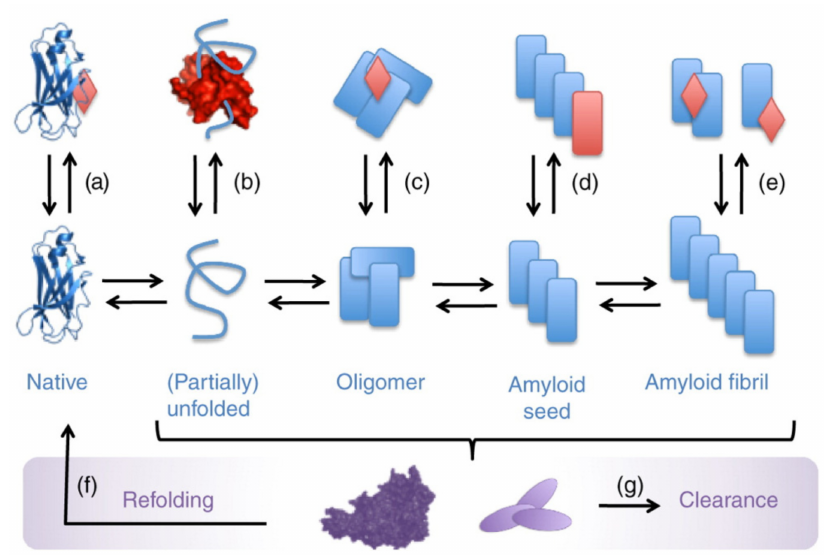
Figure 4. Schematic illustration of strategies to inhibit the formation of amyloid fibrils. (a–e) Bio- chemical mechanisms of action that could be employed by ligands (red) binding to different states of amyloid-forming peptides (blue). (a) Stabilization of the native state. (b) Sequestering of monomeric peptide. (c) Stabilization or promotion of off-pathway oligomers. (d) β -Sheet breakers that terminate fibril elongation. (e) Disassembly of amyloid fibrils. In addition, refolding (f) and clearance (g) mechanisms (purple) can be important in vivo. Reprinted with permission from ref. [119]. Copyright 2012,